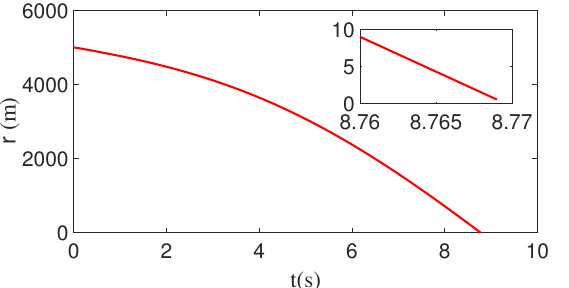
Figure 6. The normal acceleration of the missile a M and the target a T with constant maneuver.